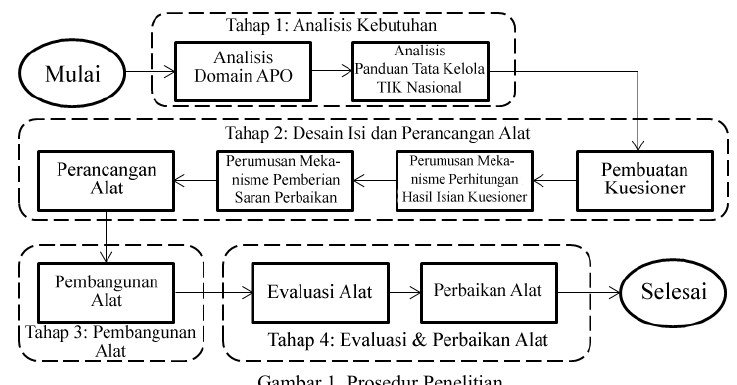
Align, Plan, and Organize